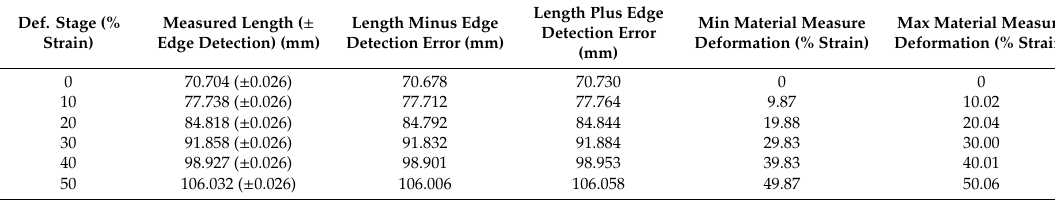
Table 3. Material measure calibration